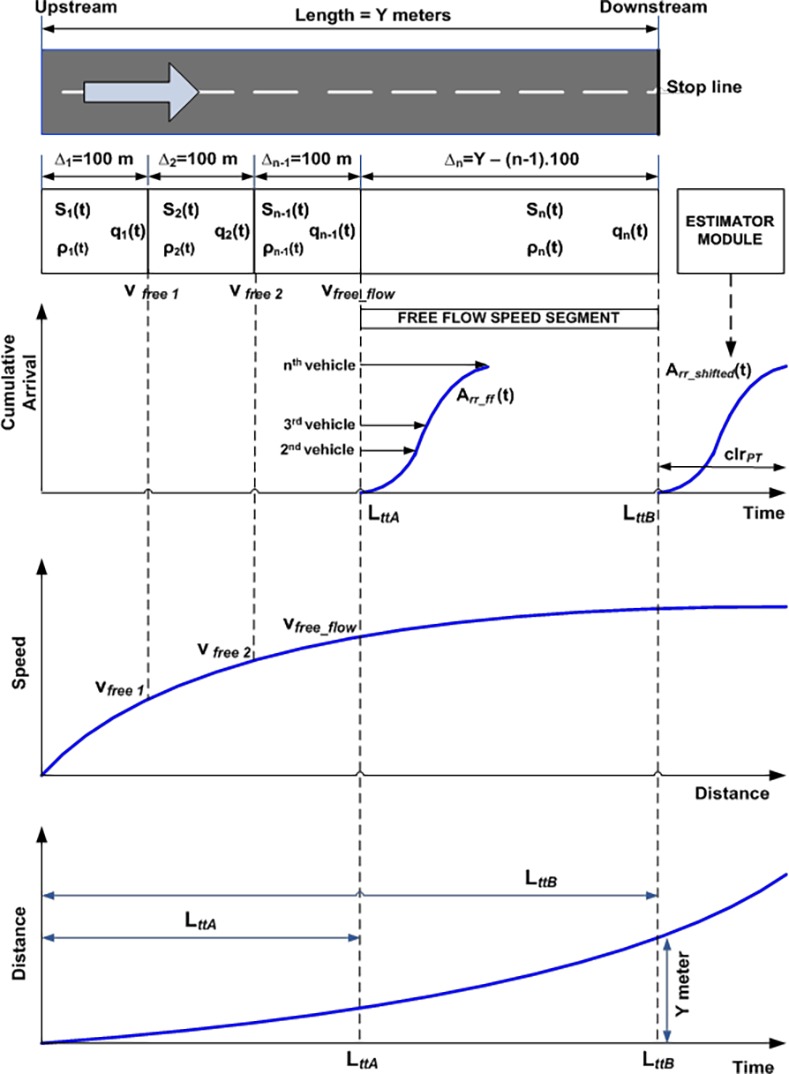
Integrated model (IM).